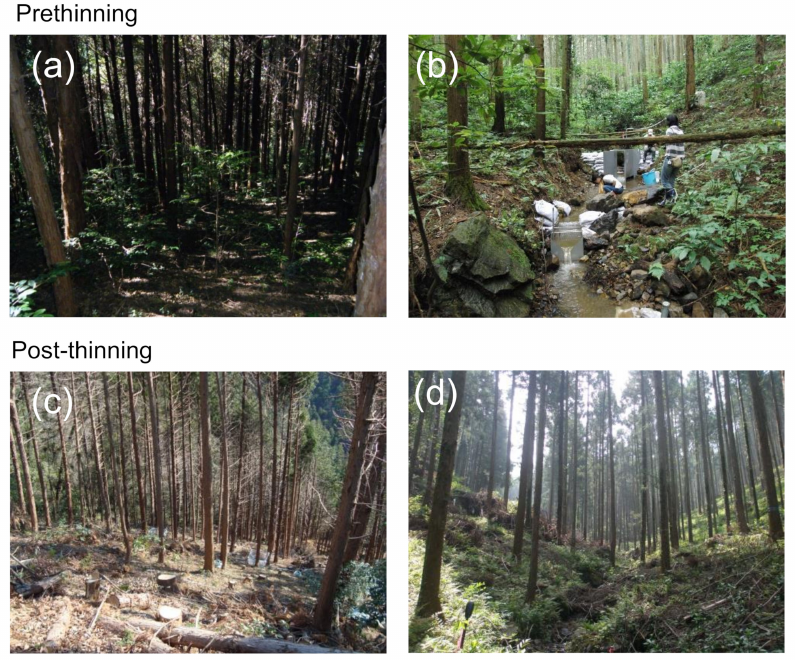
Figure 2. Overview of ( a ) hillslope and ( c ) riparian conditions before thinning and ( c ) hillslope and ( d ) riparian condition after thinning. In photo ( b ), one can also see the monitoring station of the K T catchment with combination of Parshall flume and box type V-notch